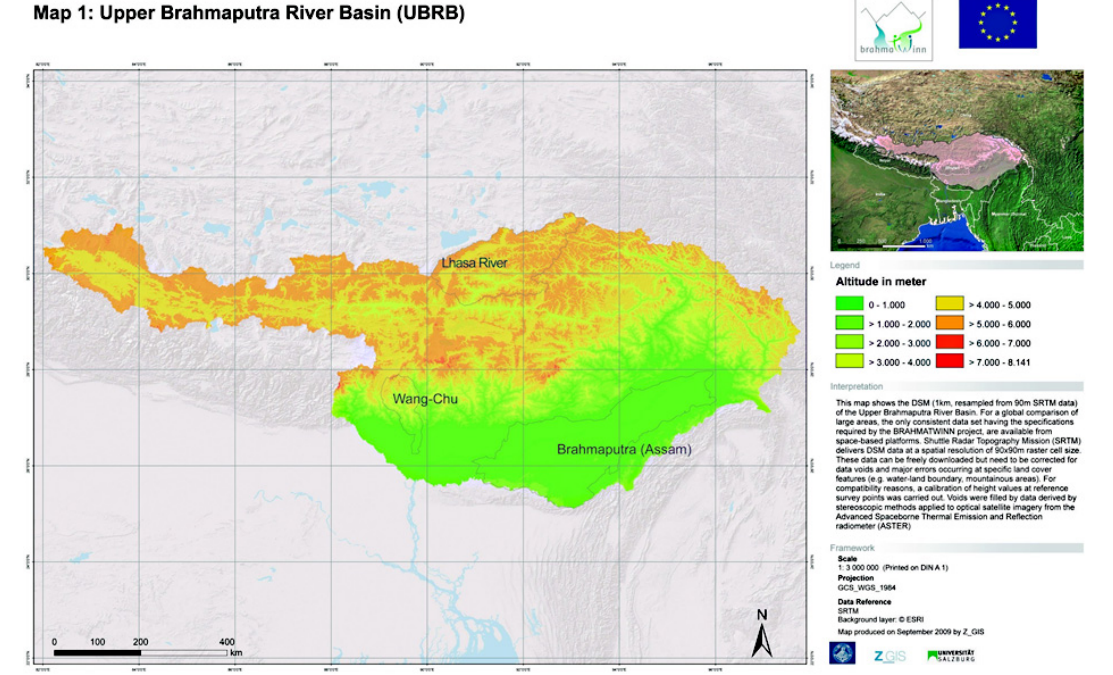
Figure 1. Digital Surface Model for the Upper Brahmaputra River Basin and reference catchments.